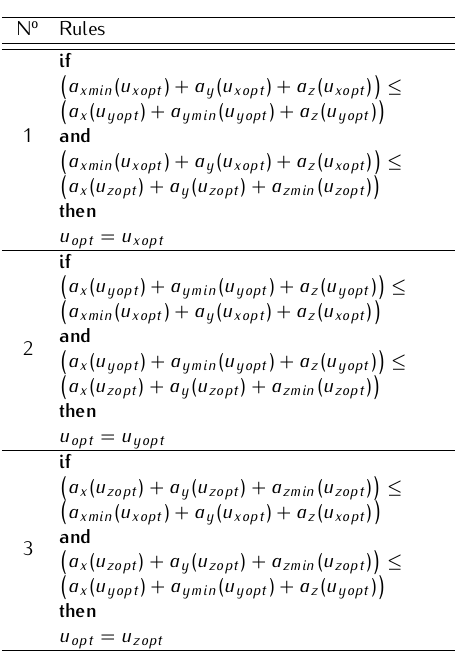
Table 1. Look-up table of rules for the U opt